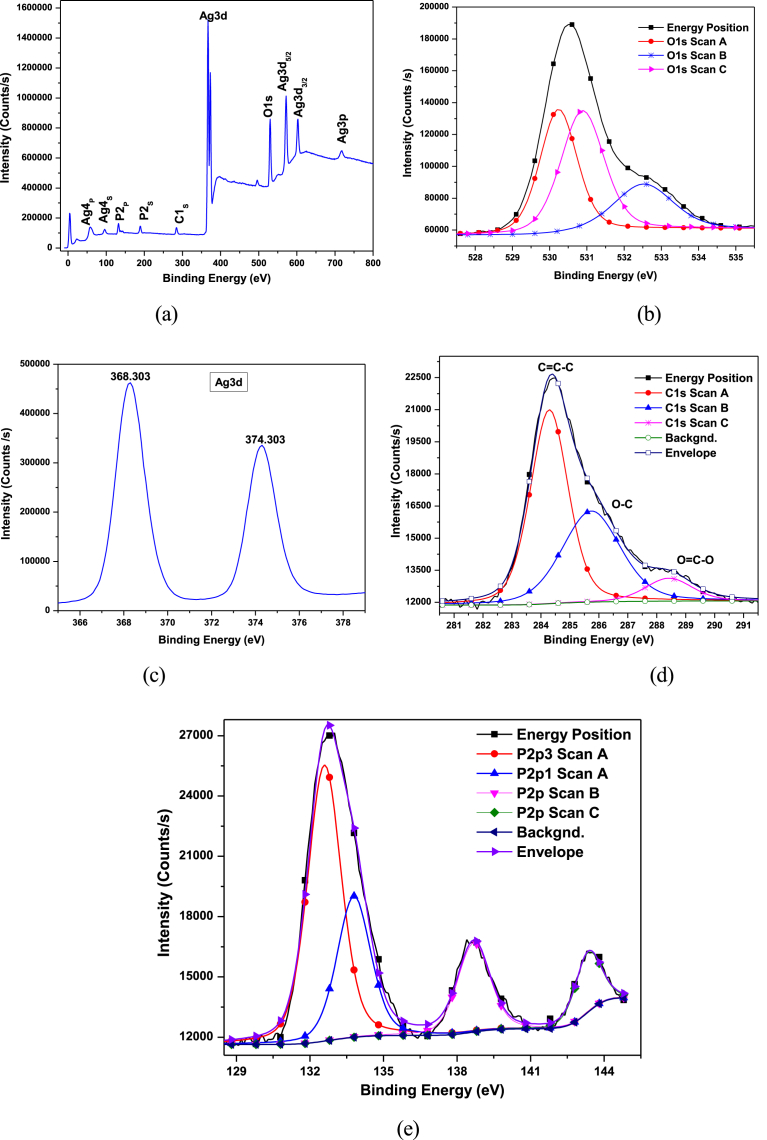
X-ray photoelectron spectra of the Ag3PO4 photocatalyst: (a) Survey XPS spectra of as prepared Ag3PO4; (b) High-resolution XPS spectra of O1s, (c) High-resolution XPS spectra of Ag3d; (d) High-resolution XPS spectra of C1s; (e) High-resolution XPS spectra of P 2p.